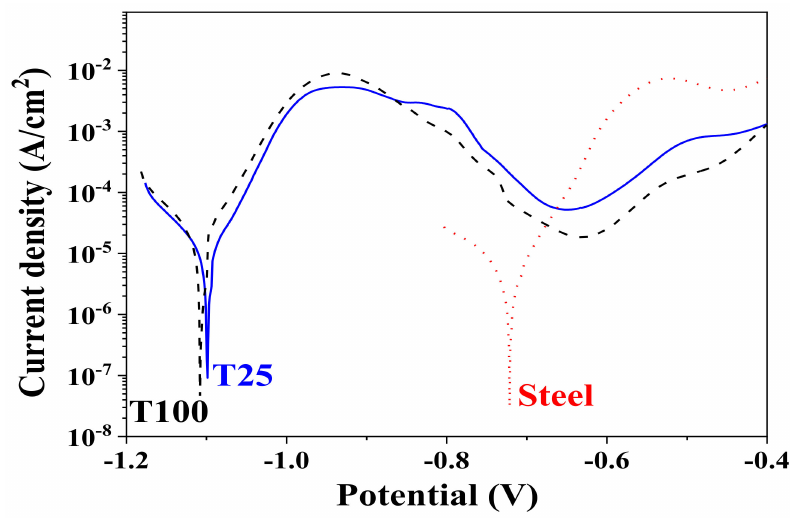
Figure 7. PD polarization curves of T25, T100 and reference steel substrate in model medium of 5 wt.% NaCl solution (Steel = low-carbon steel).